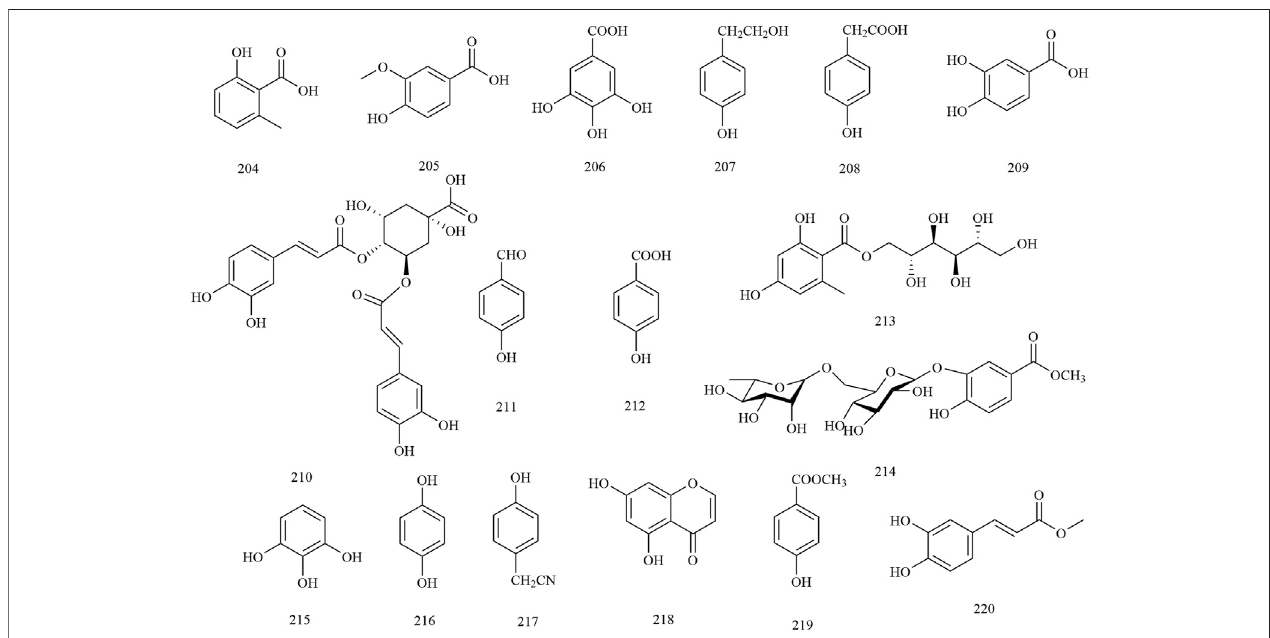
FIGURE 6 | Structures of phenolic compounds in X. sorbifolium